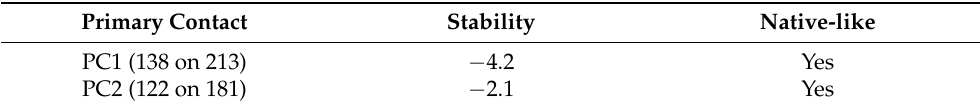
Table 1. Predicted primary contacts for m PrP(90–231) (in k